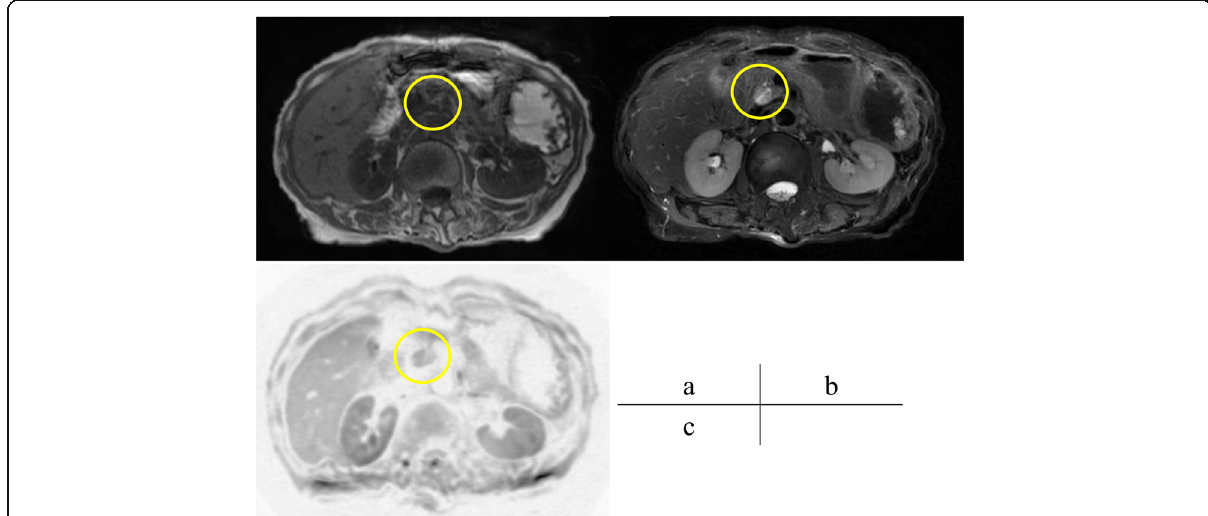
Fig. 3 Magnetic resonance imaging (MRI) showing the patient ’ s tumor with low-intensity on T1-weighted images ( a , yellow circle), heterogeneous high intensity ( b ) on T-2 weighted images, and high intensity on diffusion-weighted images ( c